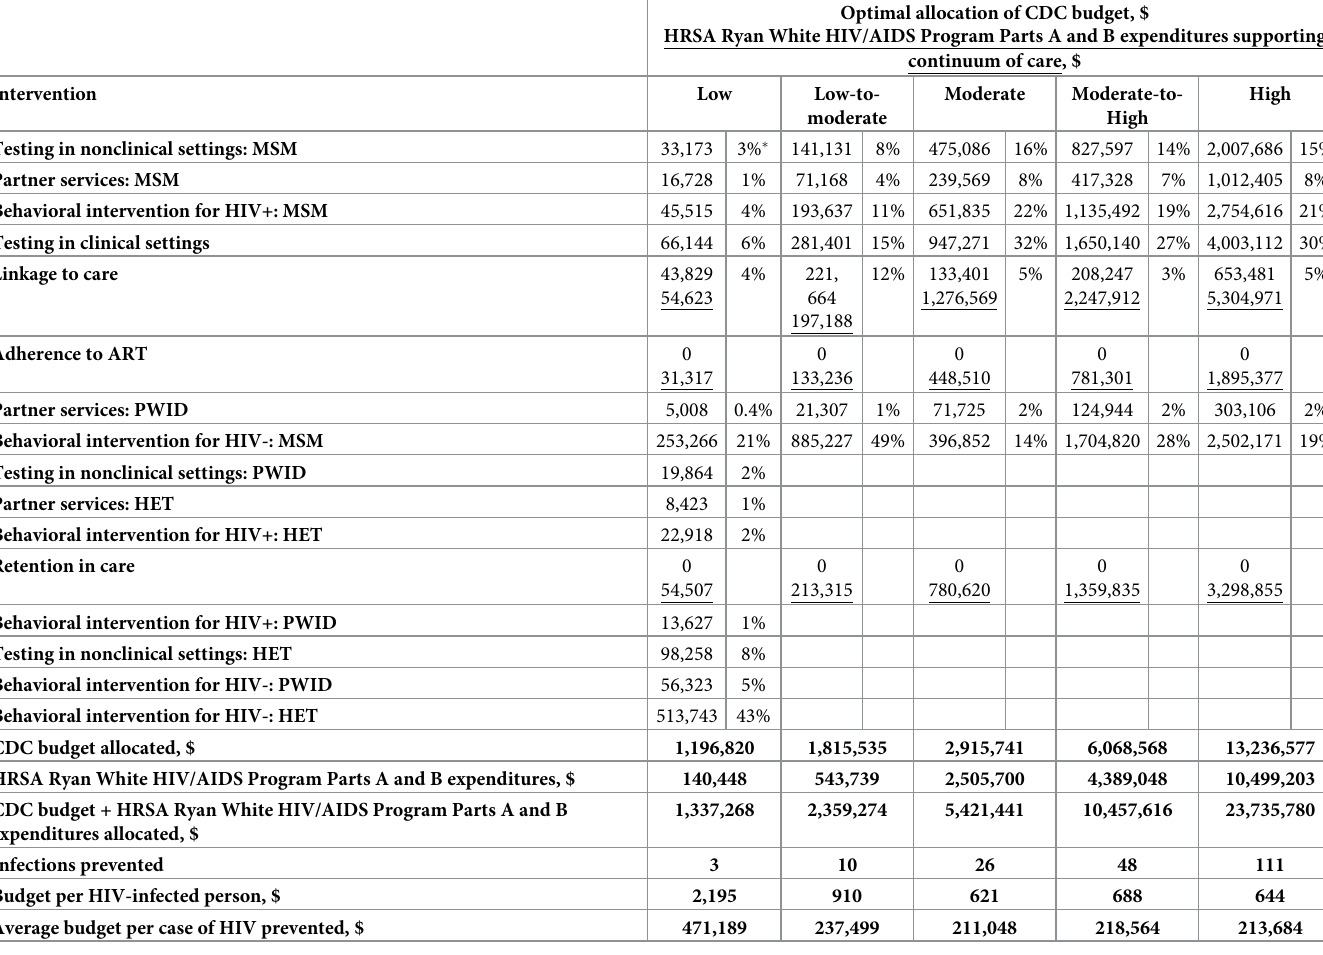
Table 4. Optimal allocation of CDC budget, allocation of HRSA Ryan White HIV/AIDS Program Parts A and B expenditures, and other model results by health department